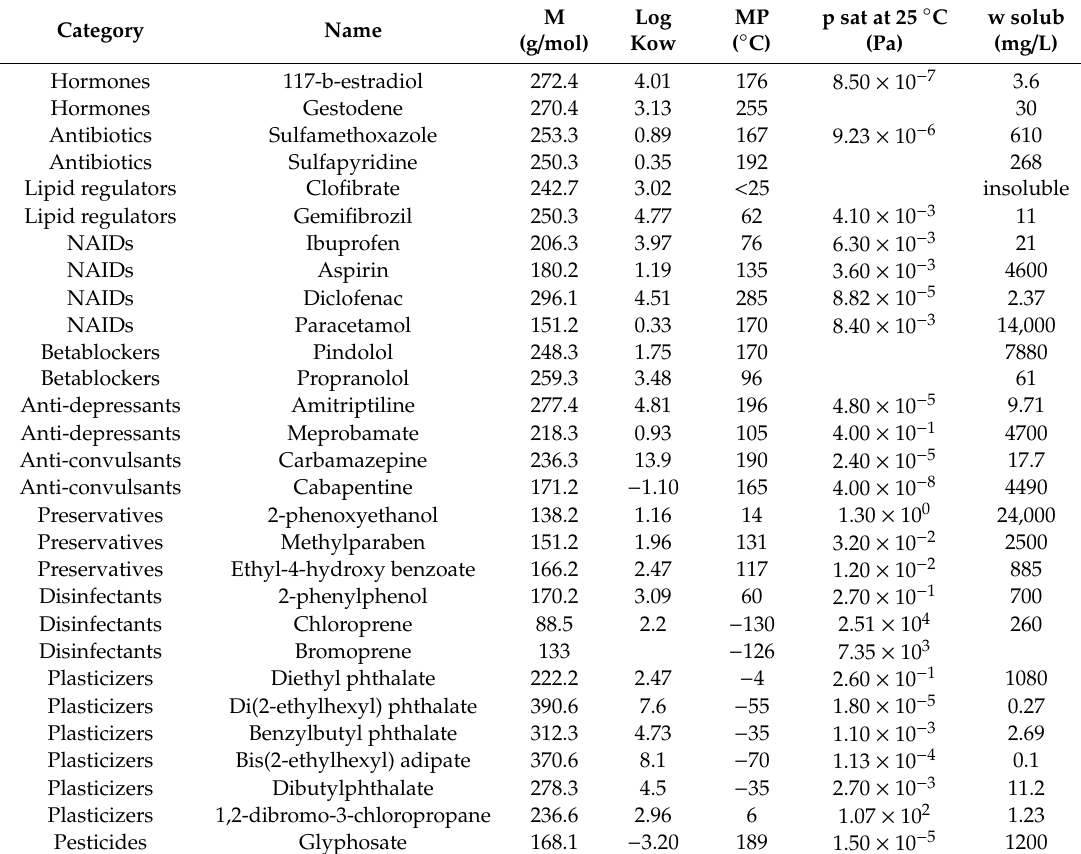
Table 1. Diversity of environmental contaminants (ECs)—physical and chemical properties of selected compounds from the group (e.g., M—molar mass; Log. Kow—octanol / water partition coe ffi cient; MP—melting point; p—pressure; w solub—water